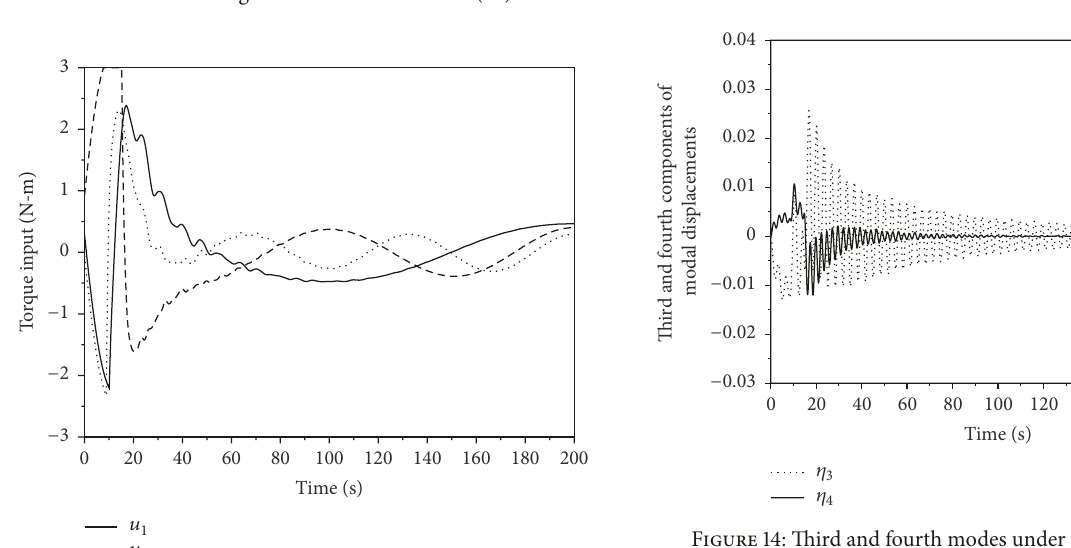
Figure 11: Sliding surface under controller (50).